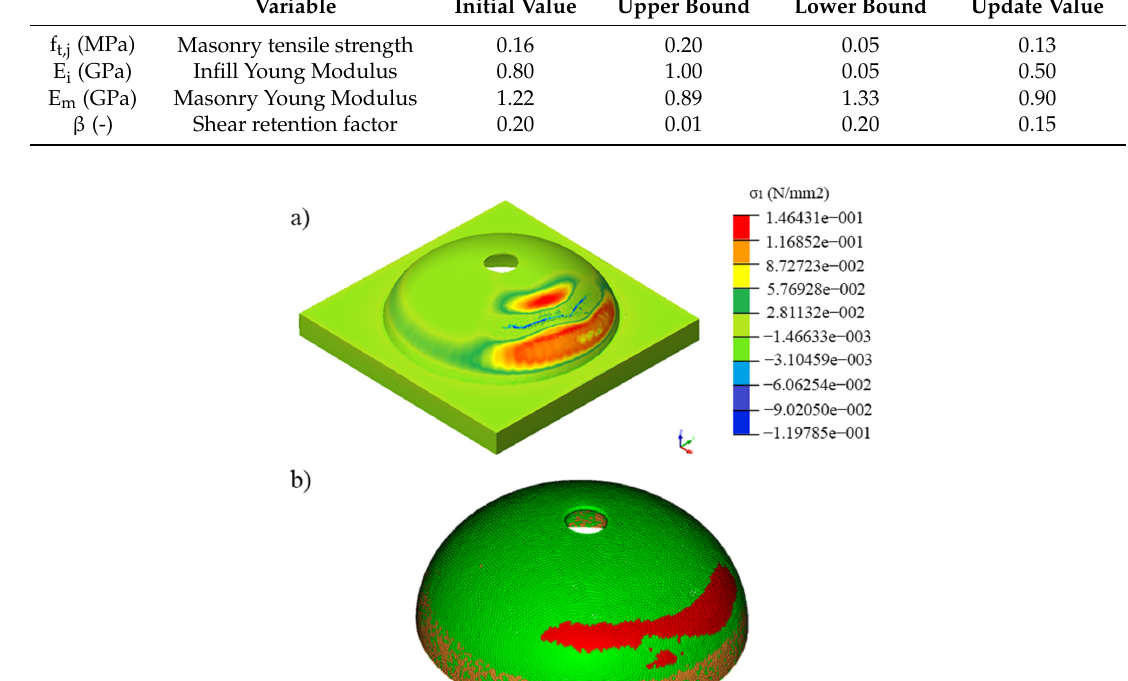
Table 6. Parameters and variables considered during the manual calibration stage.